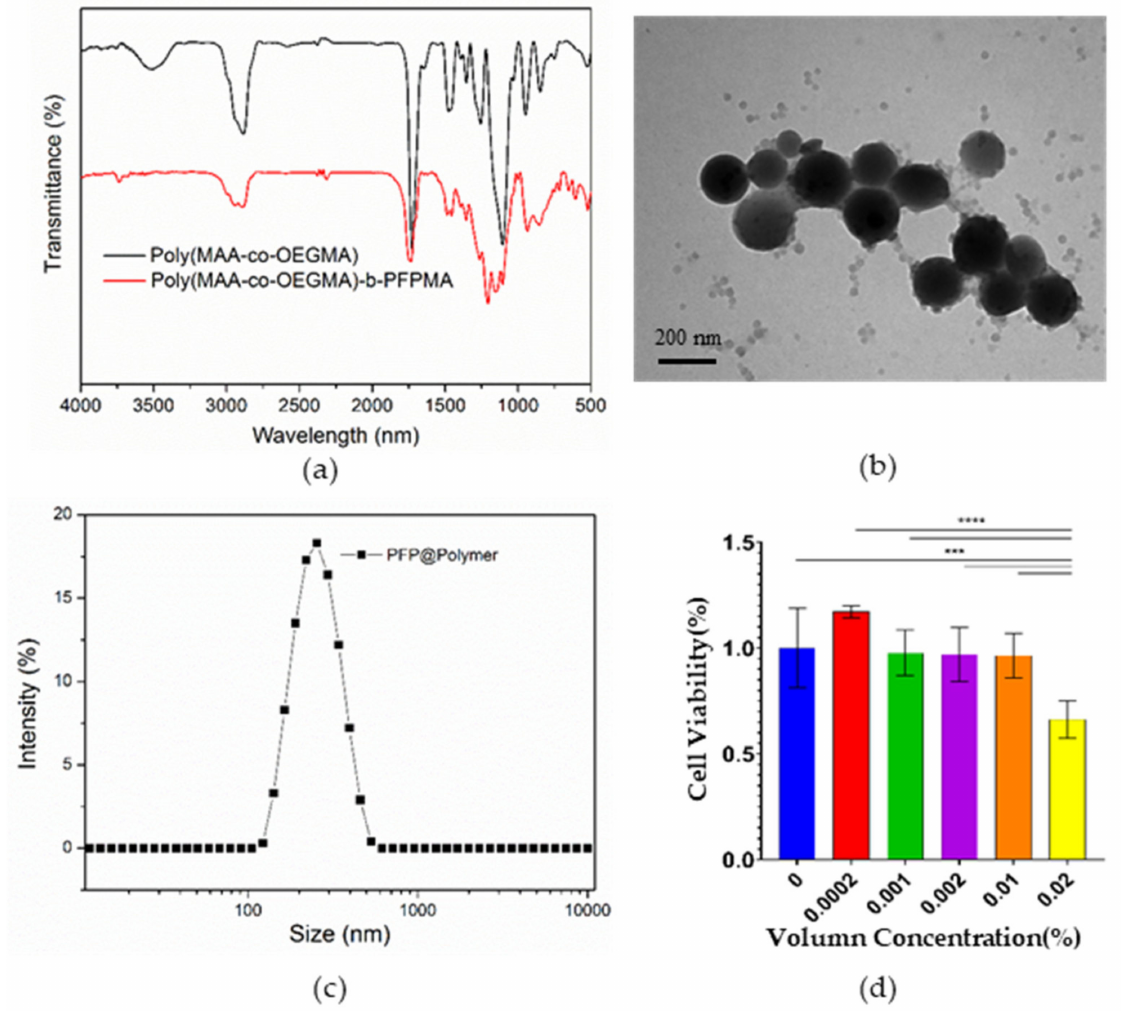
Figure 2. Characteristics of PFP@Polymer NPs. ( a ) FT-IR spectra of a polymer. ( b ) TEM image. ( c ) The size distribution. ( d ) Cytotoxicity of PFP@Polymer nanoparticles at different volume